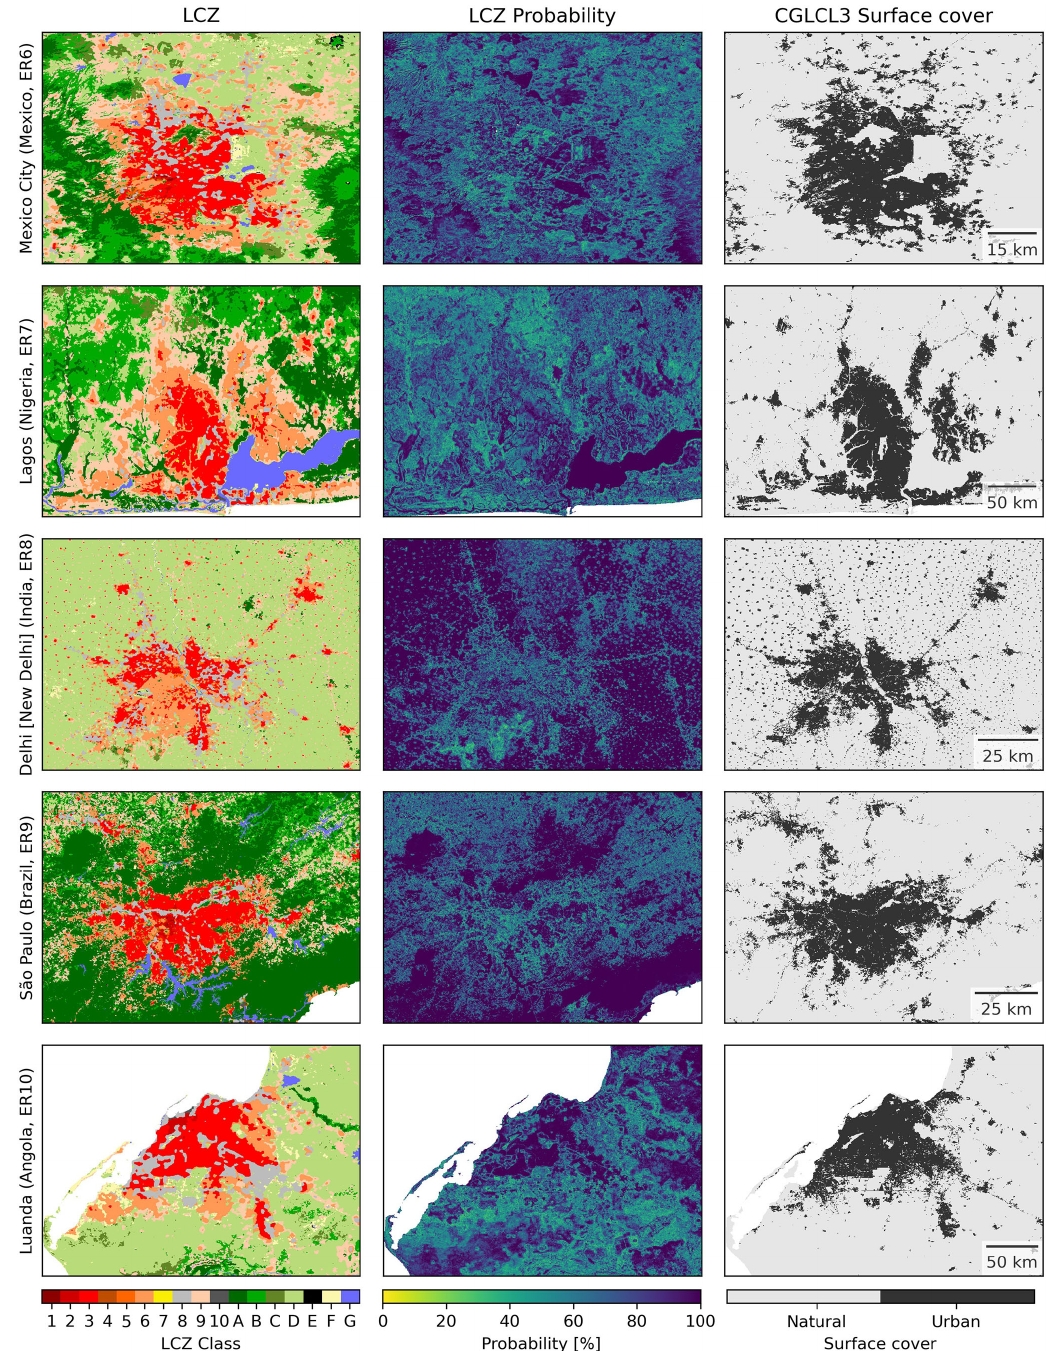
Figure 6. Like Fig. 5 but for the largest functional urban areas in urban ecoregions 6 to